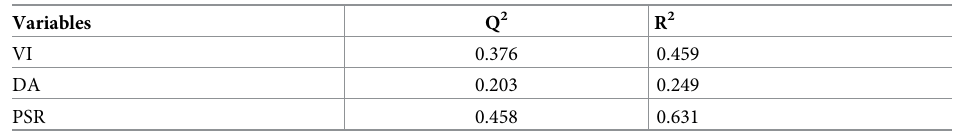
Table 5. Q 2 and R 2